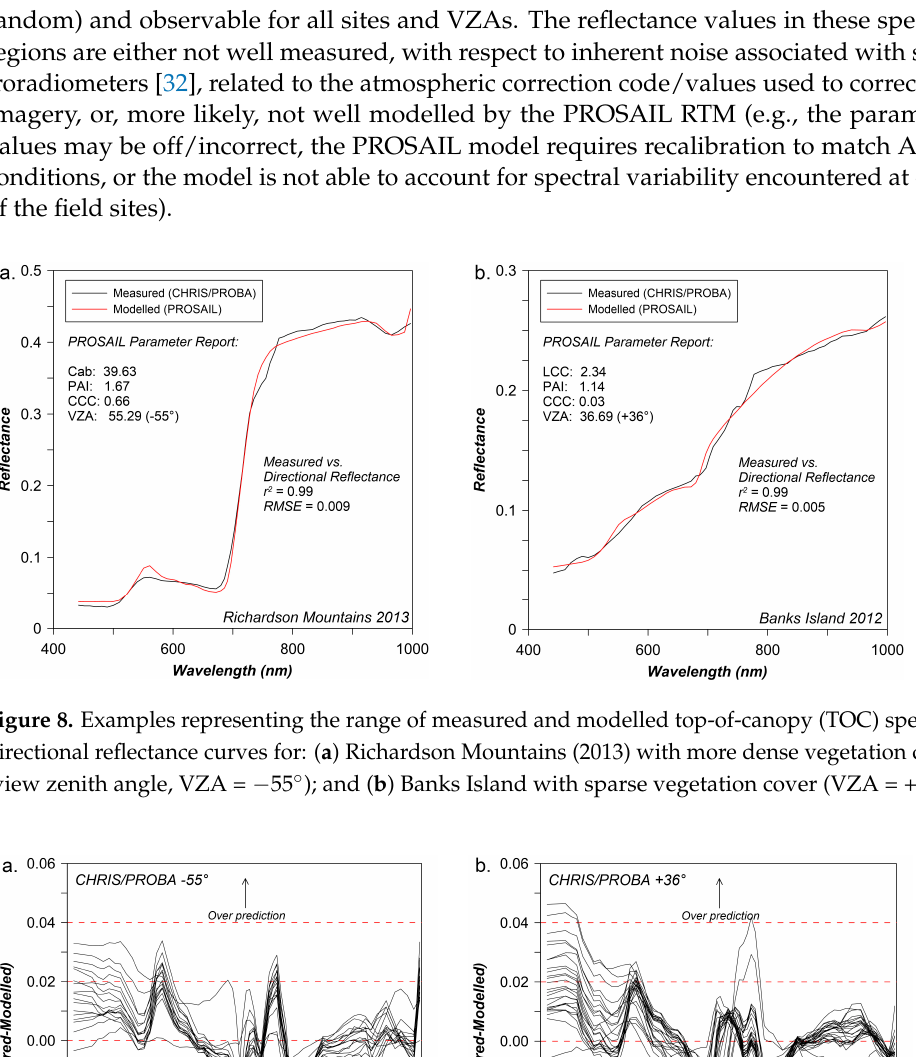
Figure 9. Difference ( Δ ) between the PROSAIL modelled and measured spectral-directional reflectance values for full spectrum CHRIS Mode-1 (M1) datasets for two example field sites and view zenith angles (VZAs): ( a ) Richardson Mountains (2013), − 55 ◦ VZA; and ( b ) Banks Island, +36 ◦ VZA. Each plot shows all modelled spectra for that location and VZA. Similar error patterns between sites and VZAs were evident. The range of differences between the modelled and measured spectra were generally about ± 0.03, with slightly larger error evident in the blue wavelengths and lower in the near-infrared (NIR). Error patterns may be related to noise associated with the CHRIS sensor (e.g., <~500